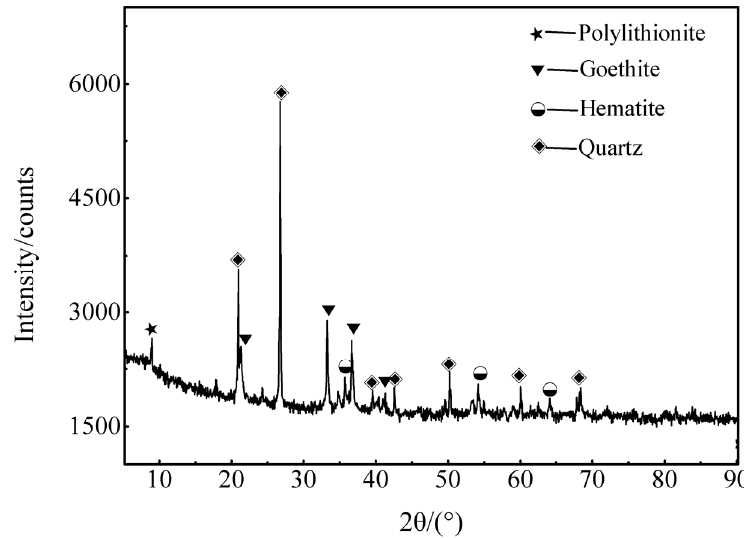
Figure 1. XRD pattern of the limonite ore. Table 2. Chemical iron phase analysis of the limonite ore (mass,